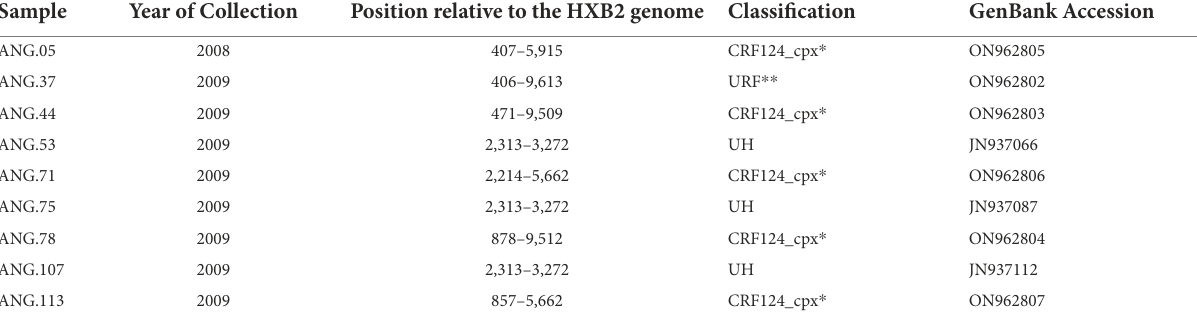
TABLE 2 Genomic data related to the studied HIV Angolan